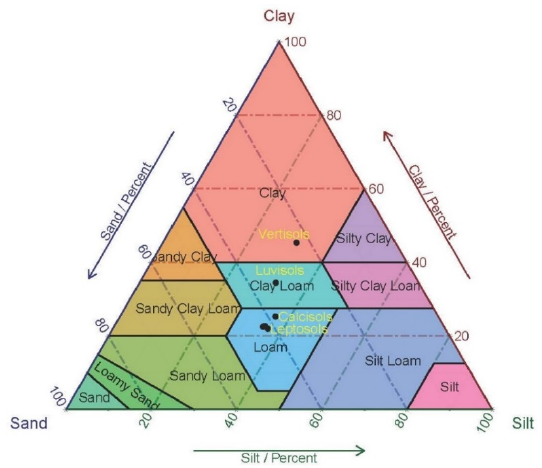
Figure 5. Soil textural classification [70]. Small dots indicate the percentage of silt, clay, and sand. Table 4. Soil group types in the study area.